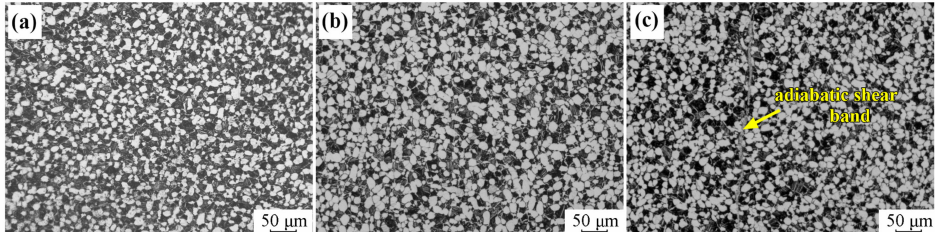
Figure 7. Microstructure of EM sample at different strain rates: ( a ) 1000 s − 1 ; ( b ) 2000 s − 1 ; ( c ) 3000 s − 1 .